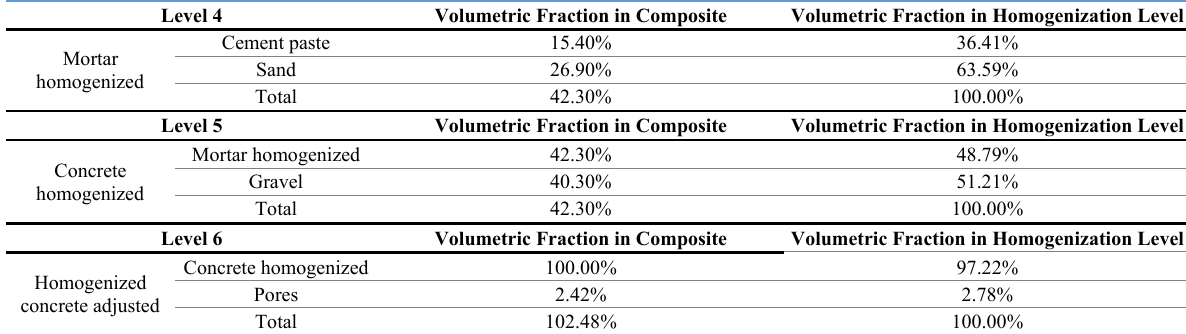
Table 4: Correction of volumetric fractions in the homogenization